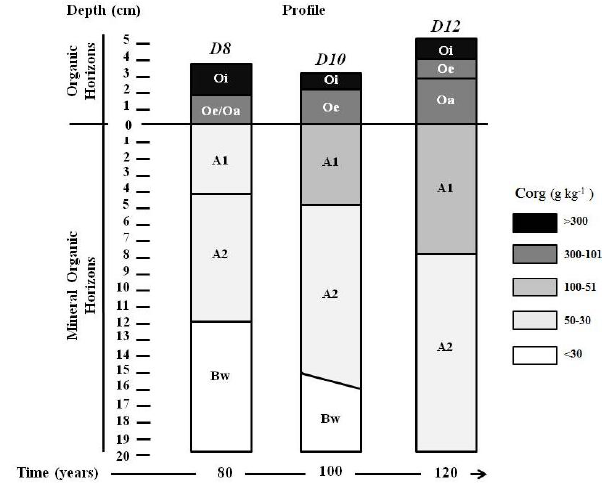
Figure 2. Soil organic and organo-mineral horizon along the Douglas fir stand chronosequence: depth and organic carbon